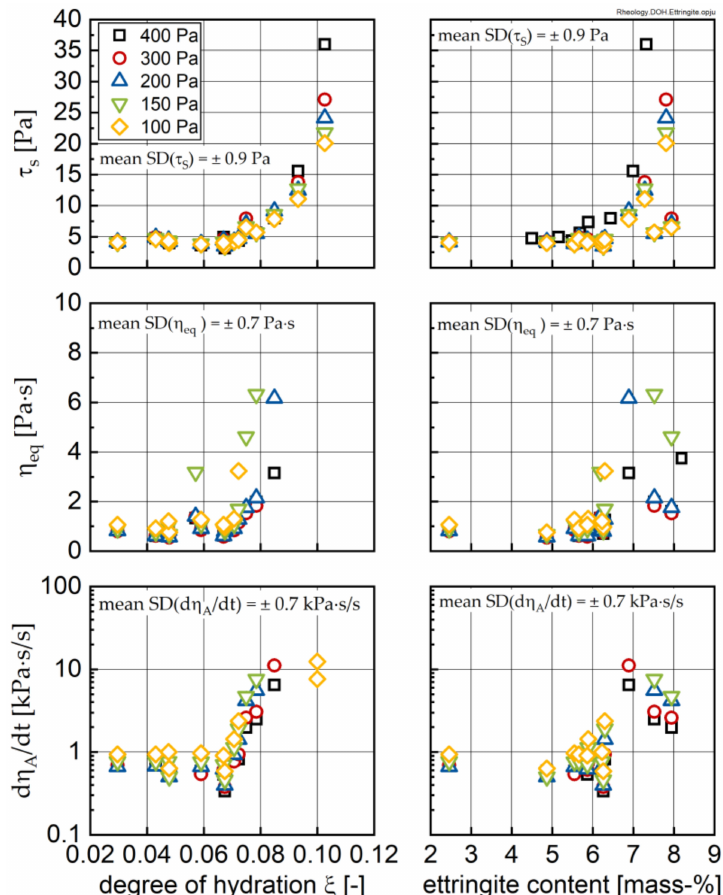
Figure 15. Structural limit stress τ s , equilibrium dynamic viscosity at defined shear load η eq and the structural recovery rate d η A / dt of the investigated cement pastes as a function of the shear stress or pre-shear stress, respectively, plotted over the degree of hydration ( left ; definition see text) and the ettringite content ( right ). Mean standard deviation (SD) calculated from three repetitions for all times, all shear stresses and all temperatures without